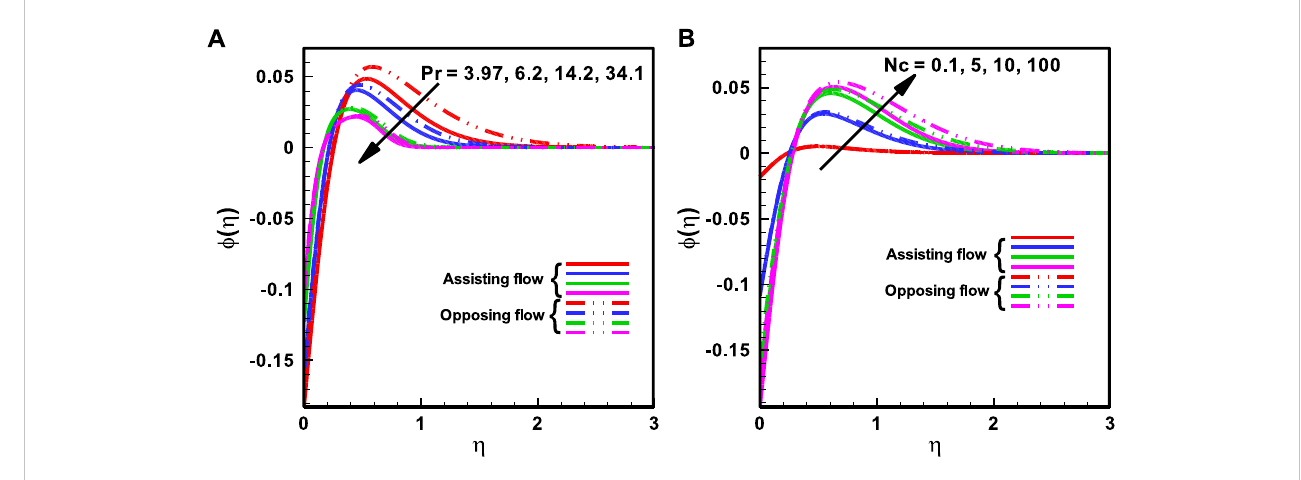
FIGURE 5 Variation of nanoparticles fraction pro fi le for (A) Prandtl number Pr (B) The ratio of buoyancy forces on the rescaled nanoparticle volume fraction Nc.